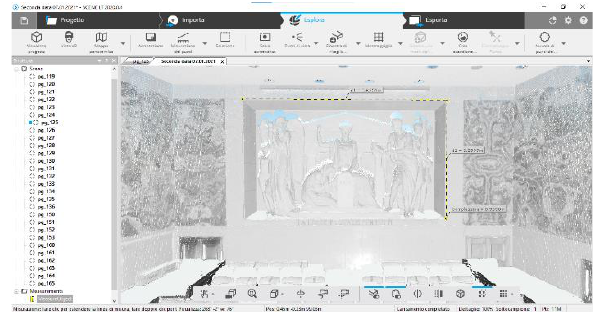
Fig 16. Example of laser scanning point cloud used to measure 3D coordinates and distances used in the photogrammetric